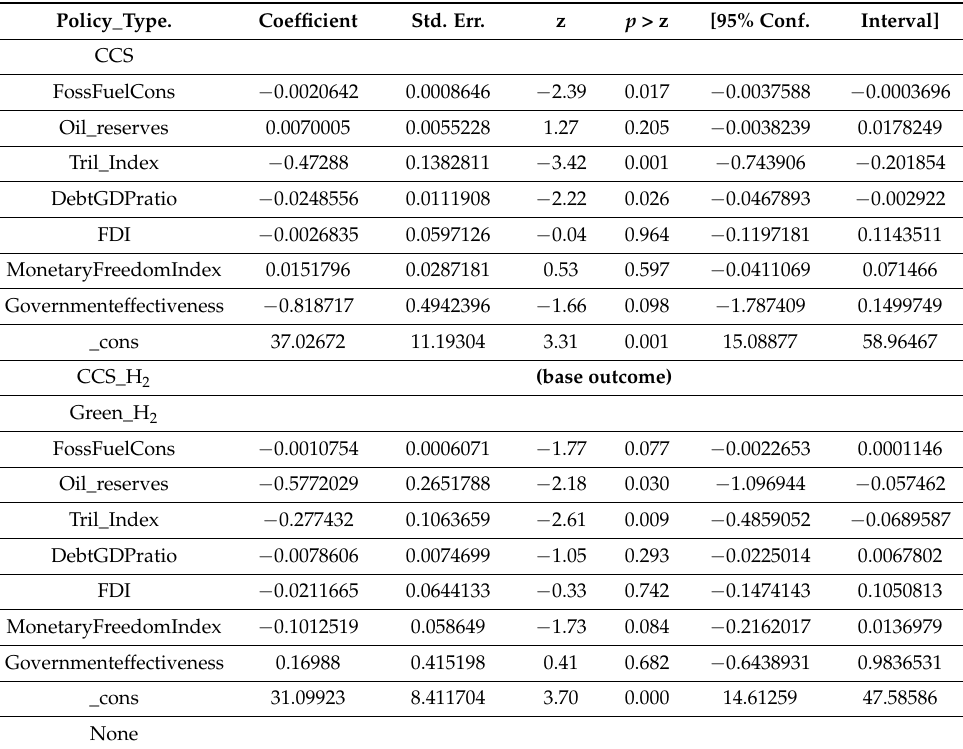
Table 8. Multinomial probit model 3